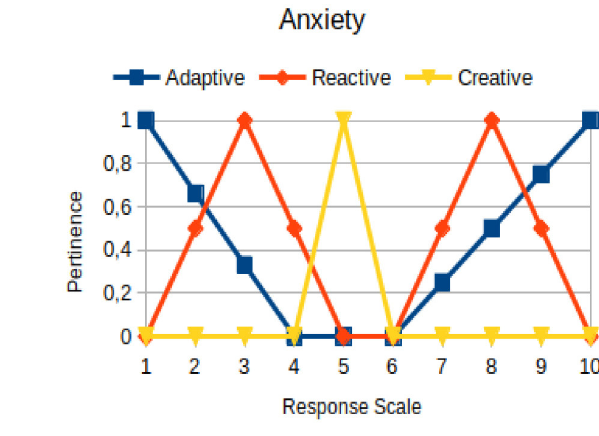
TABLE 2 | Qualitative and quantitative scheme used to collect and model the responses of an individual. Question: Are you a person that is in a constant state of alert?